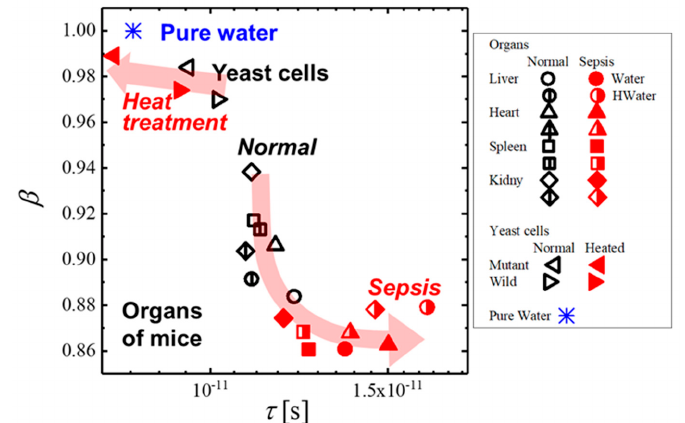
Figure 15. The τ – β diagram is for suspension of wild and mutant yeast cells and organs of mice with and without septic disease. Black and red symbols are used for yeast cells before and after heat treatment, respectively. Black and red symbols are also used for organs obtained from normal mice and those with septic disease, respectively. Two groups of mice are prepared to take usual mineral water or molecular hydrogen water before measurements. Symbols are listed in the explanatory notes.